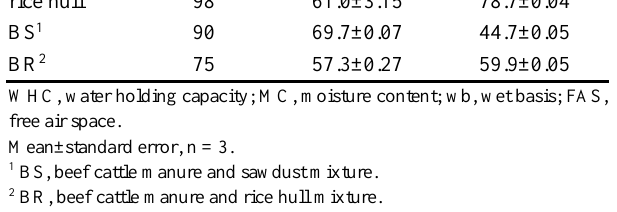
Table 2. Percentage of water holding capacity, moisture content, and free air space of samples when maximum oxygen consumption was observed % of WHC